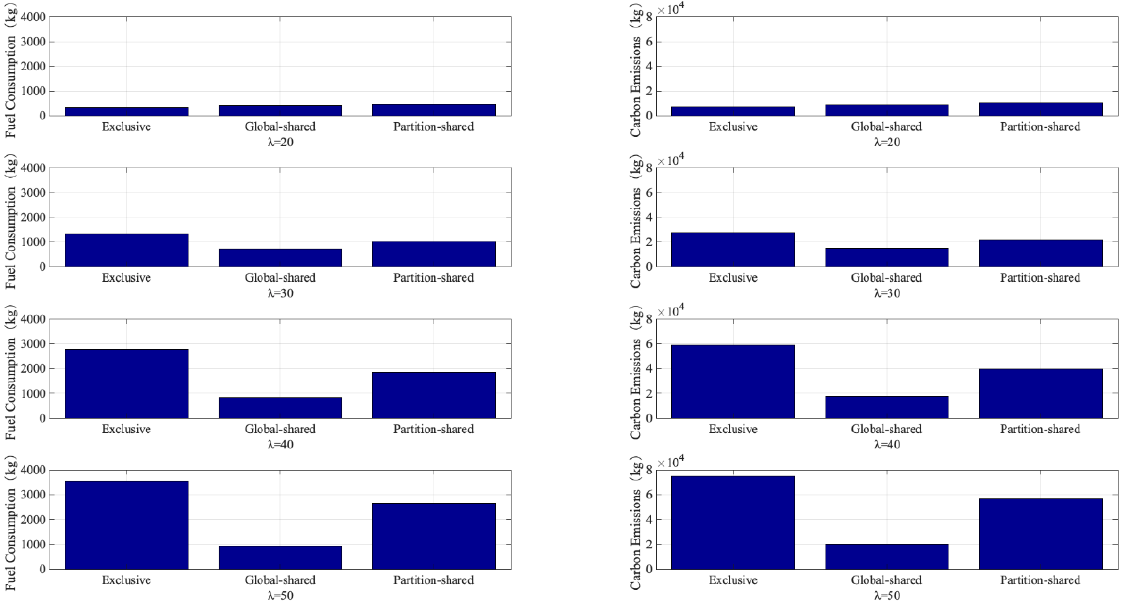
Figure 10. Aircraft Fuel Consumption and Carbon Emissions under Different Procedures and Flight Frequencies.